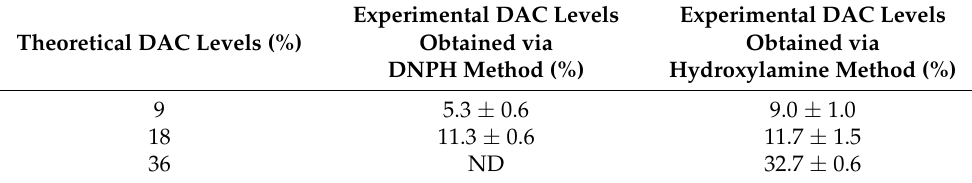
Table 1. DNPH/Hydroxylamine CHO dosage (n =